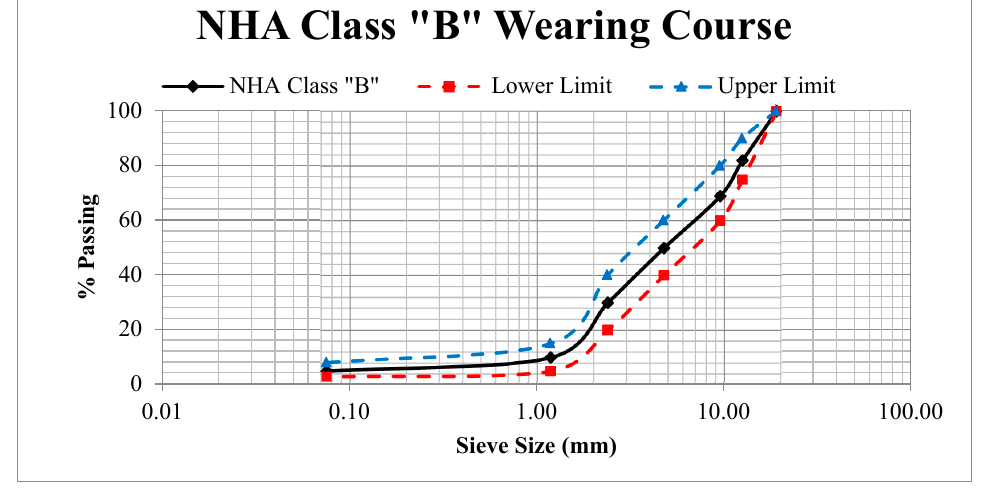
Figure 3. NHA Class B Wearing Course. Table 3. Optimum bitumen content (OBC).